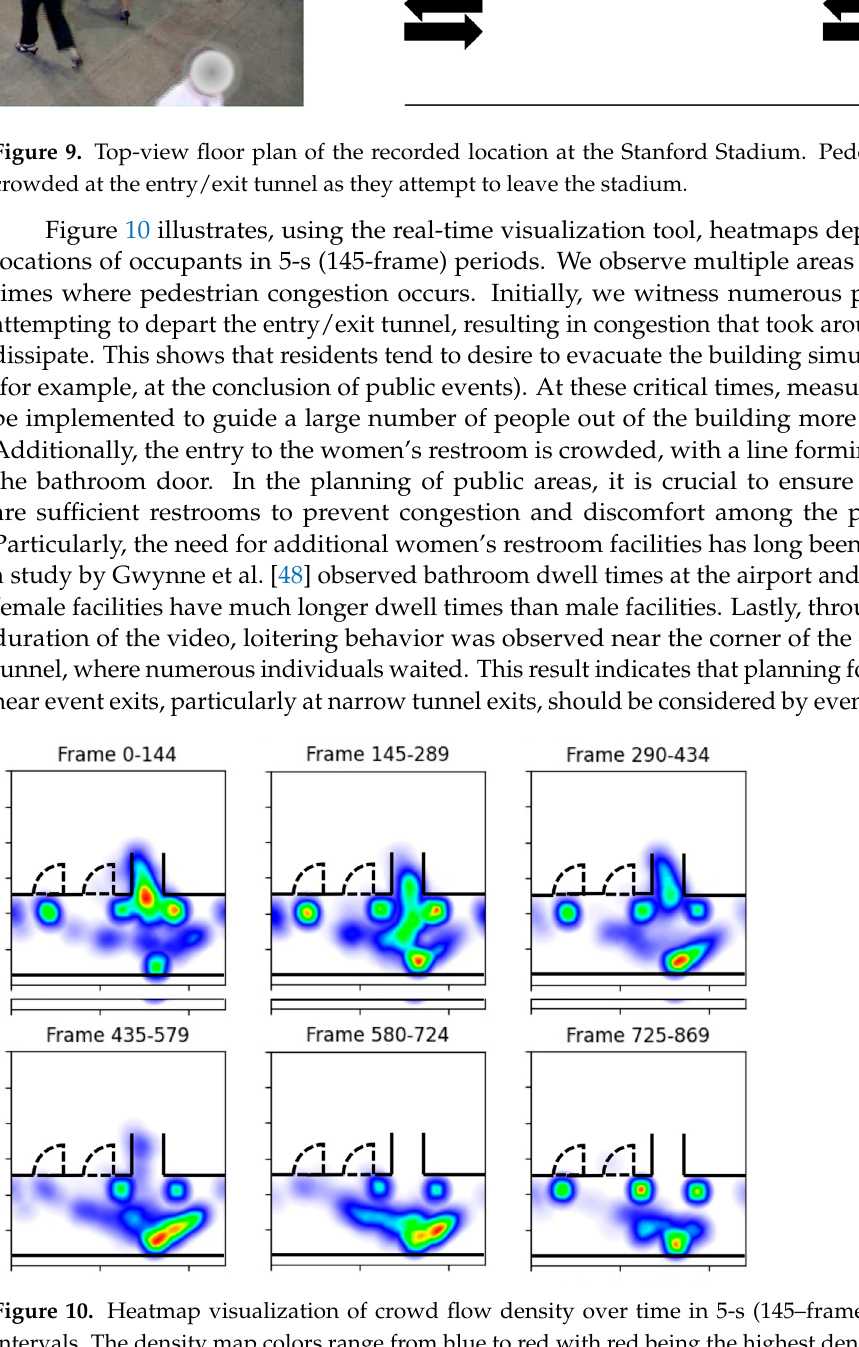
Figure 10. Heatmap visualization of crowd flow density over time in 5-s (145–frame at 29 FPS) in- tervals. The density map colors range from blue to red with red being the highest density.